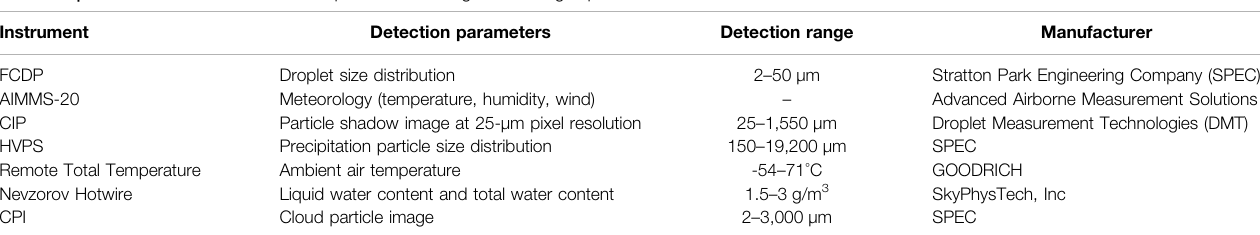
TABLE 1 | Detailed instruments and related parameters during the seeding